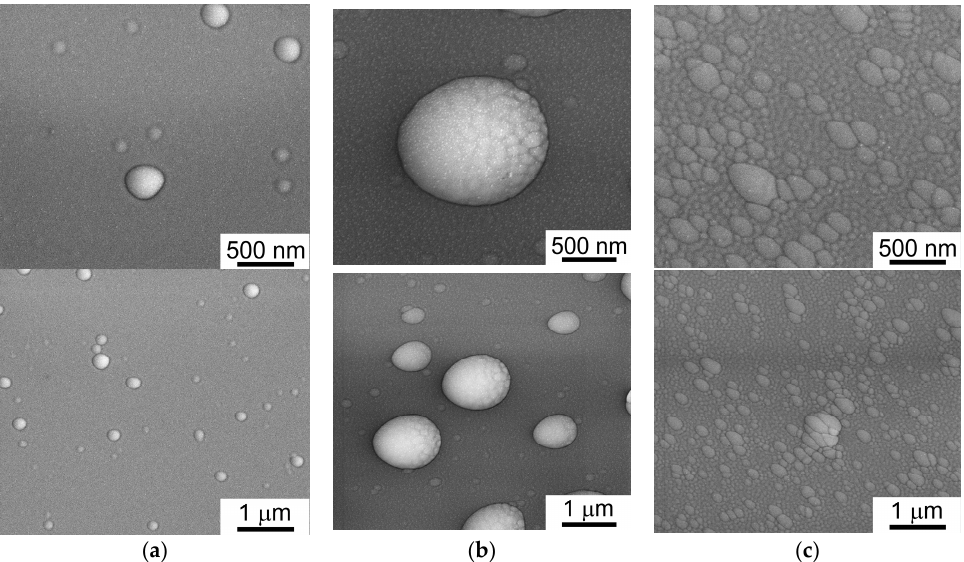
Figure 5. CaP coatings deposited on Si at a working gas pressure of 0.8 mTorr under tilt angles of 0° ( a ), 60° ( b ), or 80° ( c ) on the Si substrates.